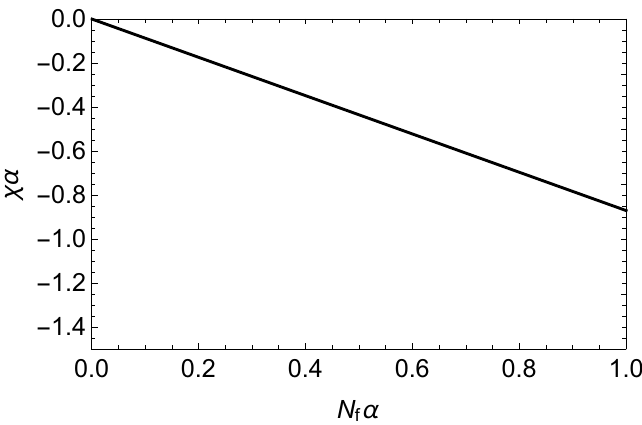
Figure 8 . The relative size (cid:31)(cid:11) of the NLO correction in large- N f QED to the ratio (cid:27)=‘ stop for the deposited charge distribution. The horizontal axis is N f (cid:11) , where it is not necessary for this ratio at this order to distinguish the precise choice of renormalization scale (or scheme) other than that (cid:22) (cid:24) (^ qE ) 1 = 4